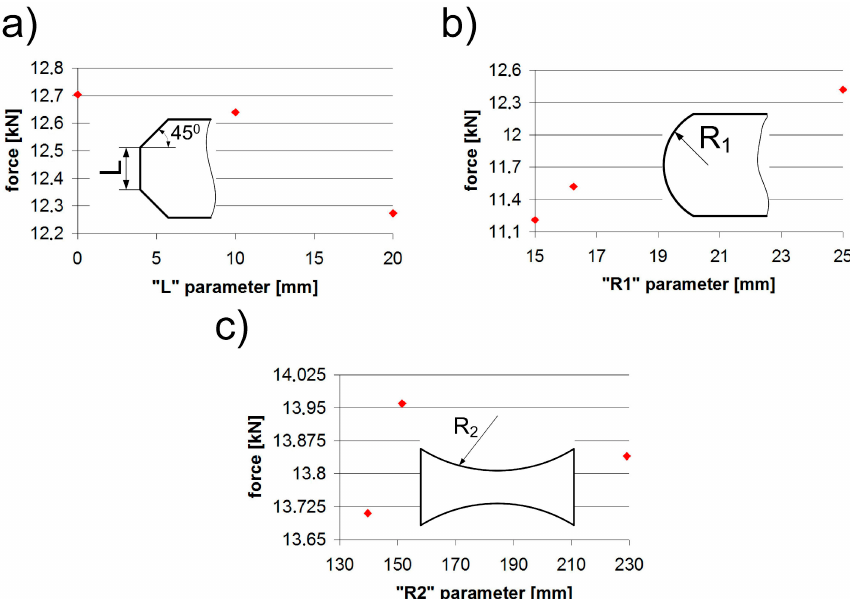
Figure 5. Influence of: ( a ) the chamfer (L), ( b ) the fillet radius (R1), and ( c ) the thinning radius (R2) parameters in pure adhesive joints. Table 5. Failure force of hybrid joints (HJ).